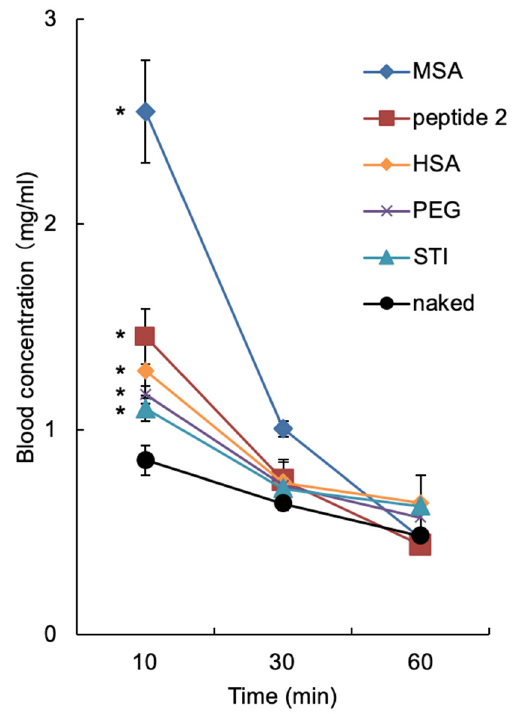
Figure 6. Blood concentration–time curves of NYO-labeled microspheres. At 10 min, 30 min, and 60 min after intravenous injection with NYO-labeled microspheres (100 μ g/mouse), blood samples were collected and processed as described in Materials and Methods. The concentrations of fluorophores were determined by a fluorescence microplate reader (n = 5; mean ± SEM; t -test, * p < 0.05).